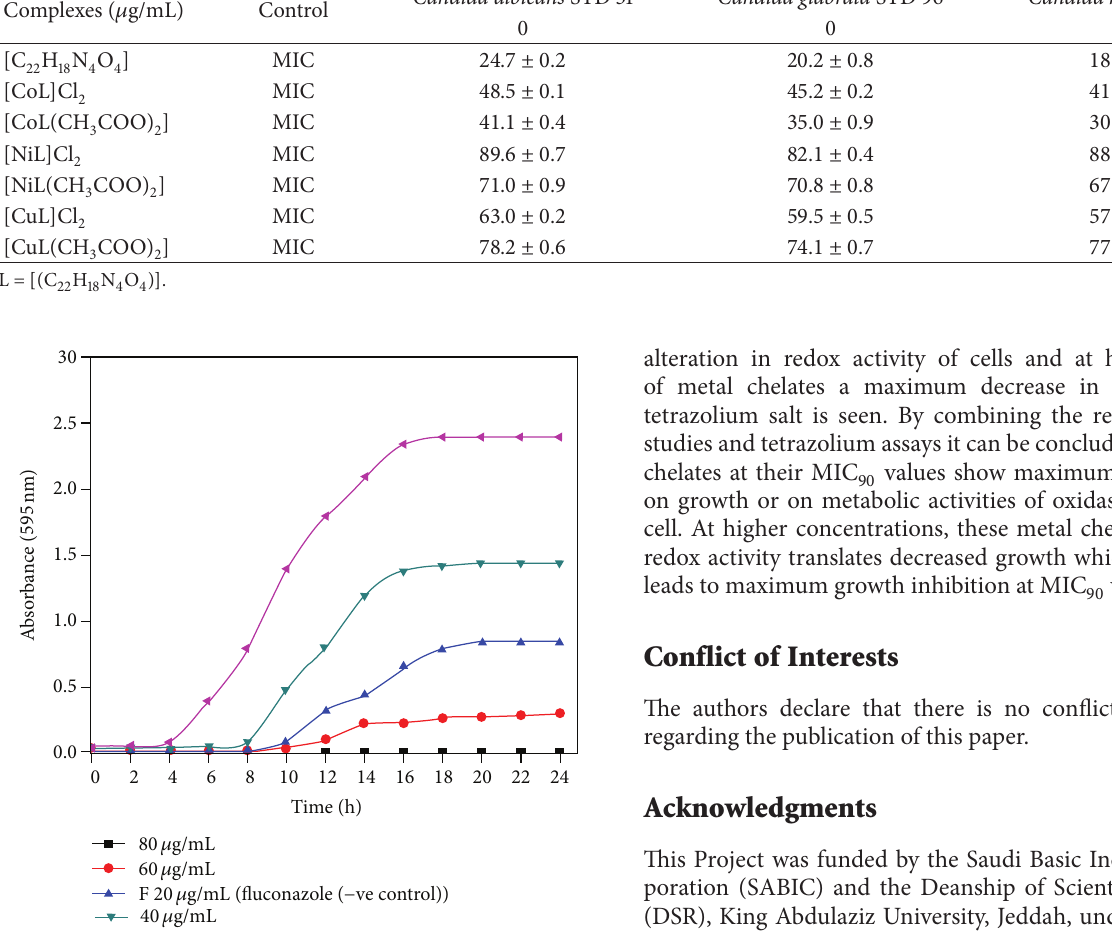
Table 4: % Cytotoxicity by MIC of ligand and its different complexes against three fluconazole-sensitive Candida isolates. Complexes ( 𝜇 g/mL)